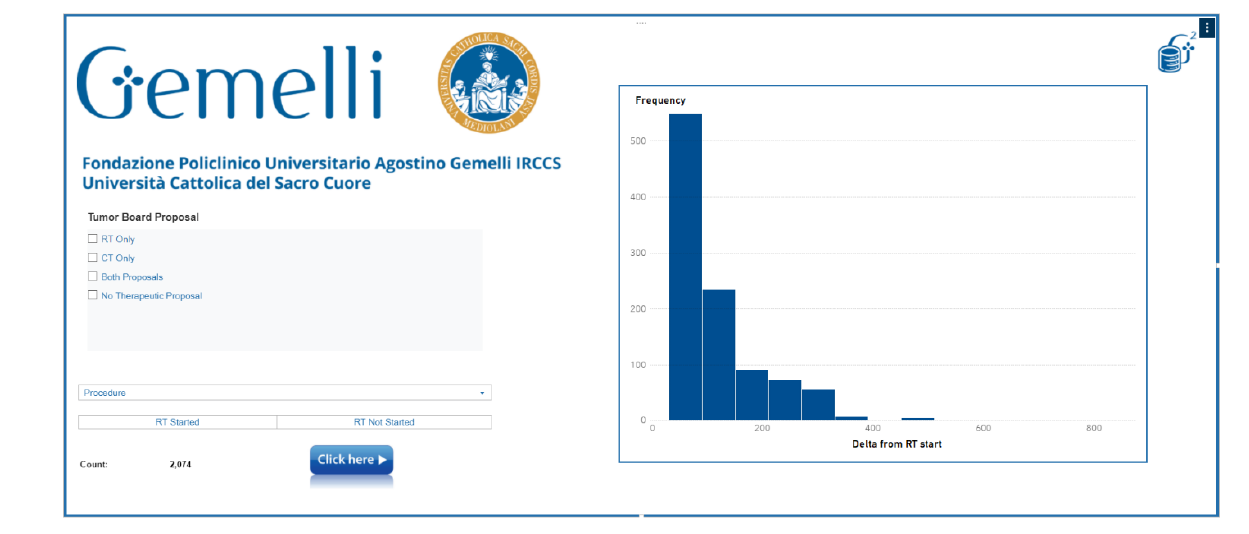
Figure 2. Waiting Time BOT platform. Table 3. KPIs